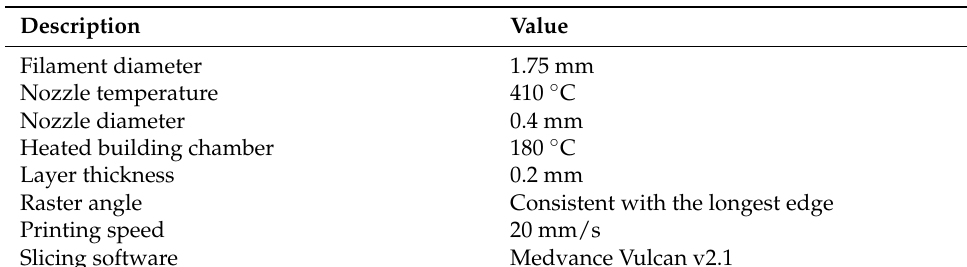
Table 2. Parameters of the 3D printing process.